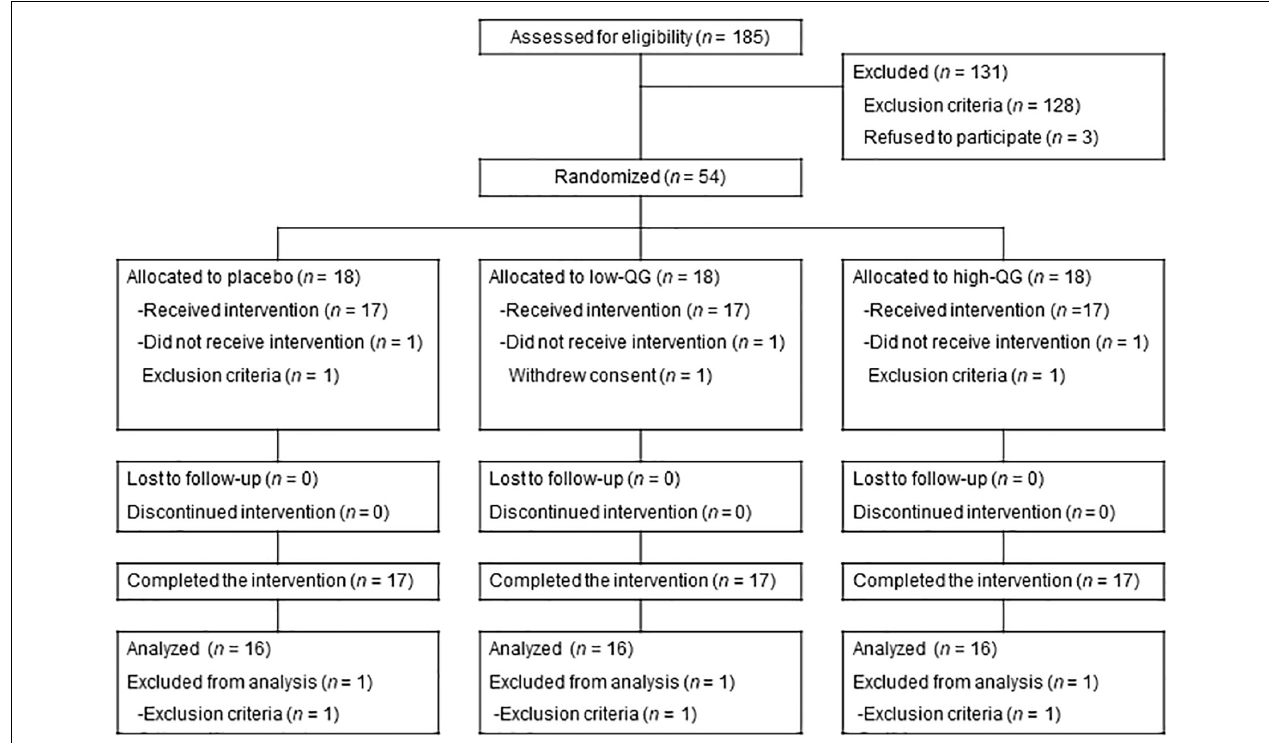
FIGURE 1 | Flowchart of this study. Of the 185 participants recruited, 54 were randomly allocated to the placebo, low-QG, and high-QG groups. QG, quercetin glycoside.